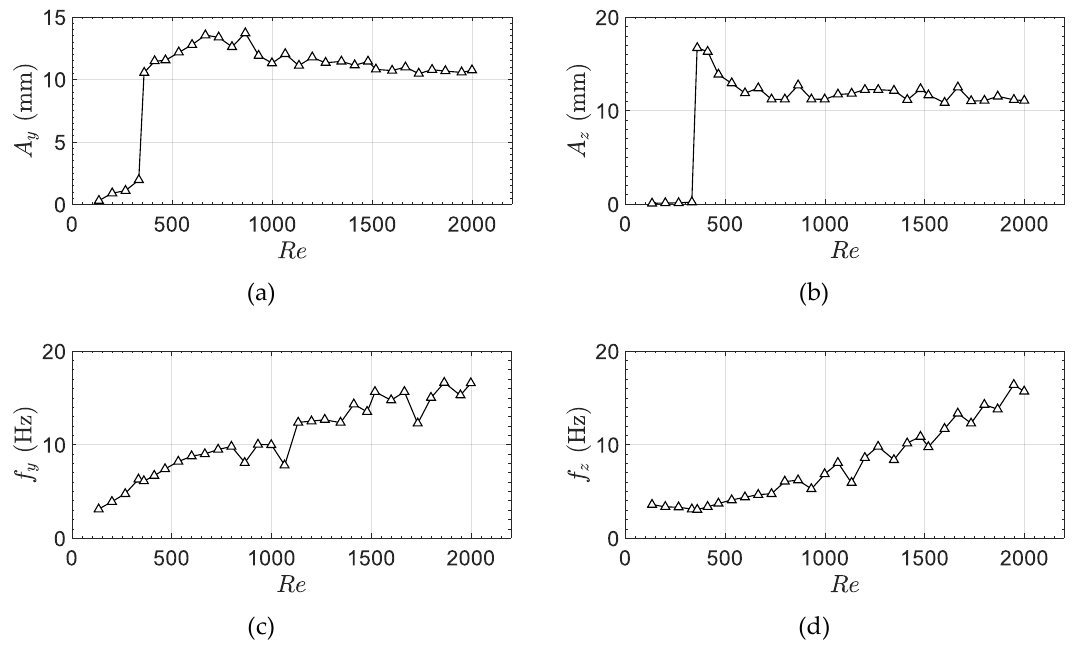
Figure 6. Displacements and flapping frequencies measured for Filament 1. ( a ) Displacement in the vertical plane; ( b) Displacement in the horizontal plane; ( c ) Frequency in the vertical plane; ( d ) Frequency in the horizontal plane. Fluids 2020 , 5 , x FOR PEER REVIEW